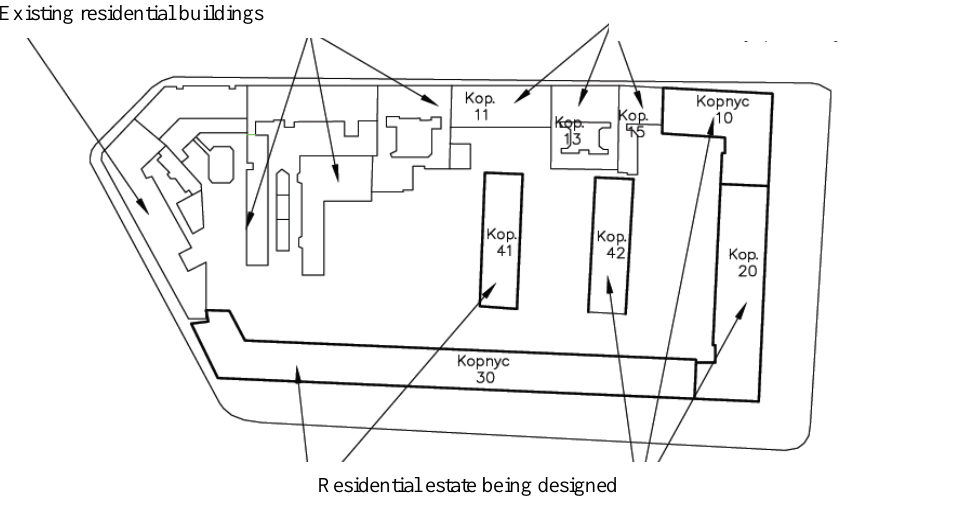
Figure 1. Schematic view of residential estate